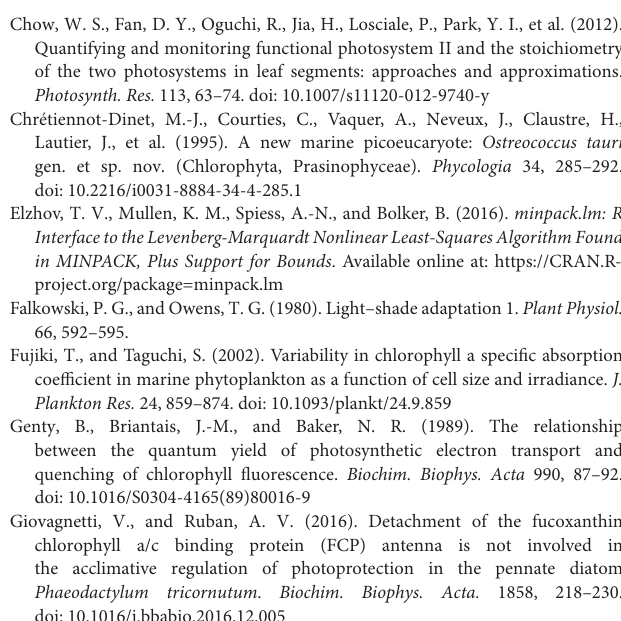
Figure S2 | σ PSII ′ 1s vs. σ PSII ′ in Prochlorococcus (A) , Synechococcus (B) , Ostreococcus (C) , or Thalassiosira (D) from growth-limiting (open triangles) or growth saturating light (open circles). σ PSII ′ was measured under increasing levels of actinic light ( Figure 1A ). σ PSII ′ 1s was measured after 1s of darkness following each actinic light level ( Figure 1A ). Paired determinations from 4 to 8 replicate cultures plotted individually. Figure S3 | The normalized second derivative of whole cell spectra of Thalassiosira from growth-limiting (A,C) or growth saturating light (B,D) . Samples were treated without or with dithiothreitol (DTT) to develop or inhibit the deepoxidation of the xanthophyll cycle. The whole cell spectra were measured before (solid line) and after (dashed line) 8min of actinic light treatment. Average of paired determinations from 2 to 3 replicate cultures plotted. Figure S4 | The normalized second derivative of whole cell spectra of Synechococcus from growth-limiting (solid line) or growth saturating light (dotted line). Average of paired determinations from 2 to 3 replicate cultures plotted. Figure S5 | The normalized second derivative of whole cell spectra of Ostreococcus from growth-limiting (A,C) or growth saturating light (B,D) . Samples were treated without or with dithiothreitol (DTT) to develop or inhibit the deepoxidation of the xanthophyll cycle. The whole cell spectra were measured before (solid line) and after (dashed line) 8min of actinic light treatment. Average of paired determinations from 2 to 3 replicate cultures plotted. Figure S6 | σ PSII ′ 1s vs. YNPQ 1s in Prochlorococcus (A) , Synechococcus (B) , Ostreococcus (C) , or Thalassiosira (D) from growth-limiting (open triangles) or growth saturating light (open circles). Induction of YNPQ 1s was driven by increasing actinic light ( Figure 1A ). Paired determinations from 4 to 8 replicate cultures plotted individually. Solid lines show linear regressions; dotted lines show 95% C.I. on the regression lines. Figure S7 | σ PSII ′ vs. YNPQ in (A) in Chlorella vulgaris , (B) Haslea ostrearia , (C) Haslea sp. (Indonesian strain), or (D) Micromonas NCMA 2099 (arctic strain growing at 2C). Induction of YNPQ was driven by increasing actinic light. Paired determinations from 3 to 15 cultures of each strain plotted individually and fitted with a linear regression (solid line); 95% C.I. on the regression shown by dotted